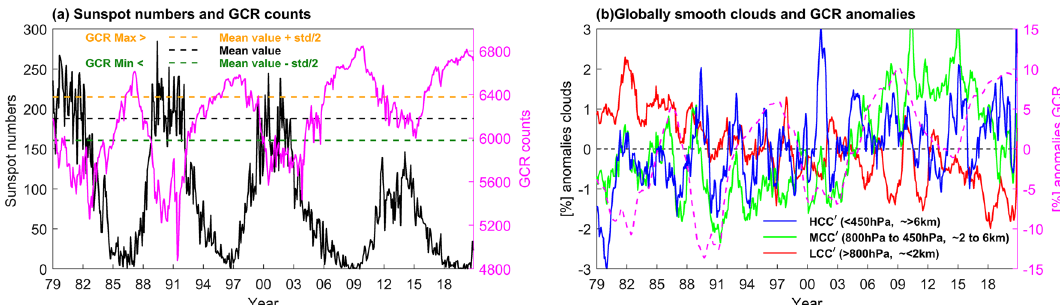
Figure 1. ( a ) Monthly time variation of sunspot number (black curve) and GCR count (pink curve) for the period 1979–2020. The black dashed line is the time mean value of GCR counts, while the gold and green dashed lines indicate one-half standard deviation above and below the mean, defining groups of maximum and minimum GCR, respectively. ( b ) The red, green, and blue lines represent the global mean, twelve month ′ ′ ′ smoothed cloud anomalies (in %) of the LCC , MCC and HCC , respectively, while the pink dashed line with ′ right side y-axis represents the GCR anomalies (in